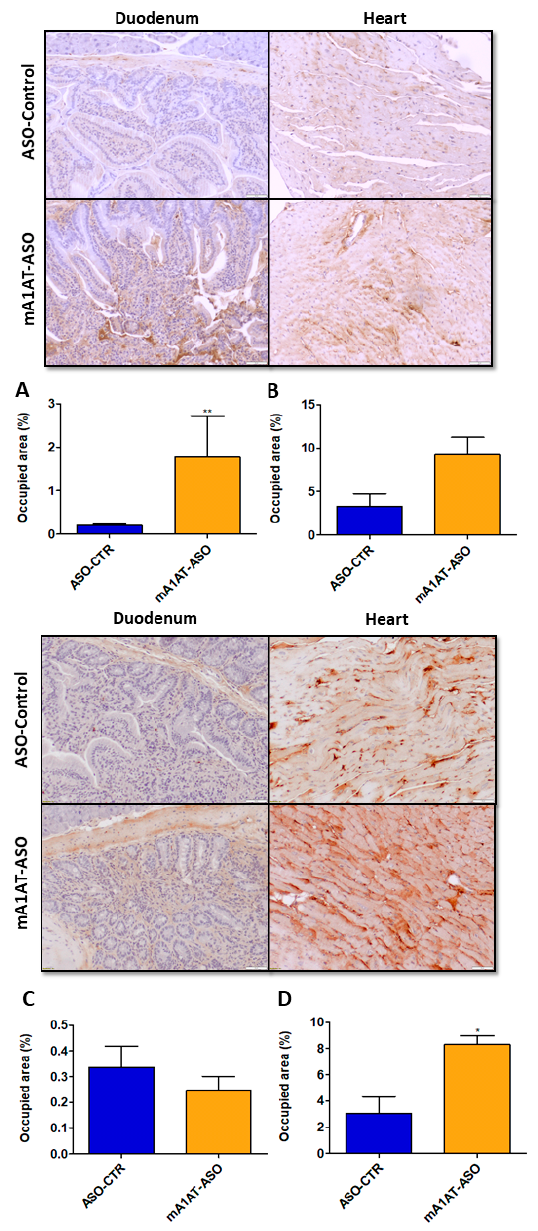
Figure 5. Transthyretin deposition is increased upon SerpinA1 knockdown in the mouse heart of older animals. Representative images of immunohistochemical analysis of mouse heart and duodenum upon the administration of antisense oligonucleotides targeting SerpinA1 to young (12–13